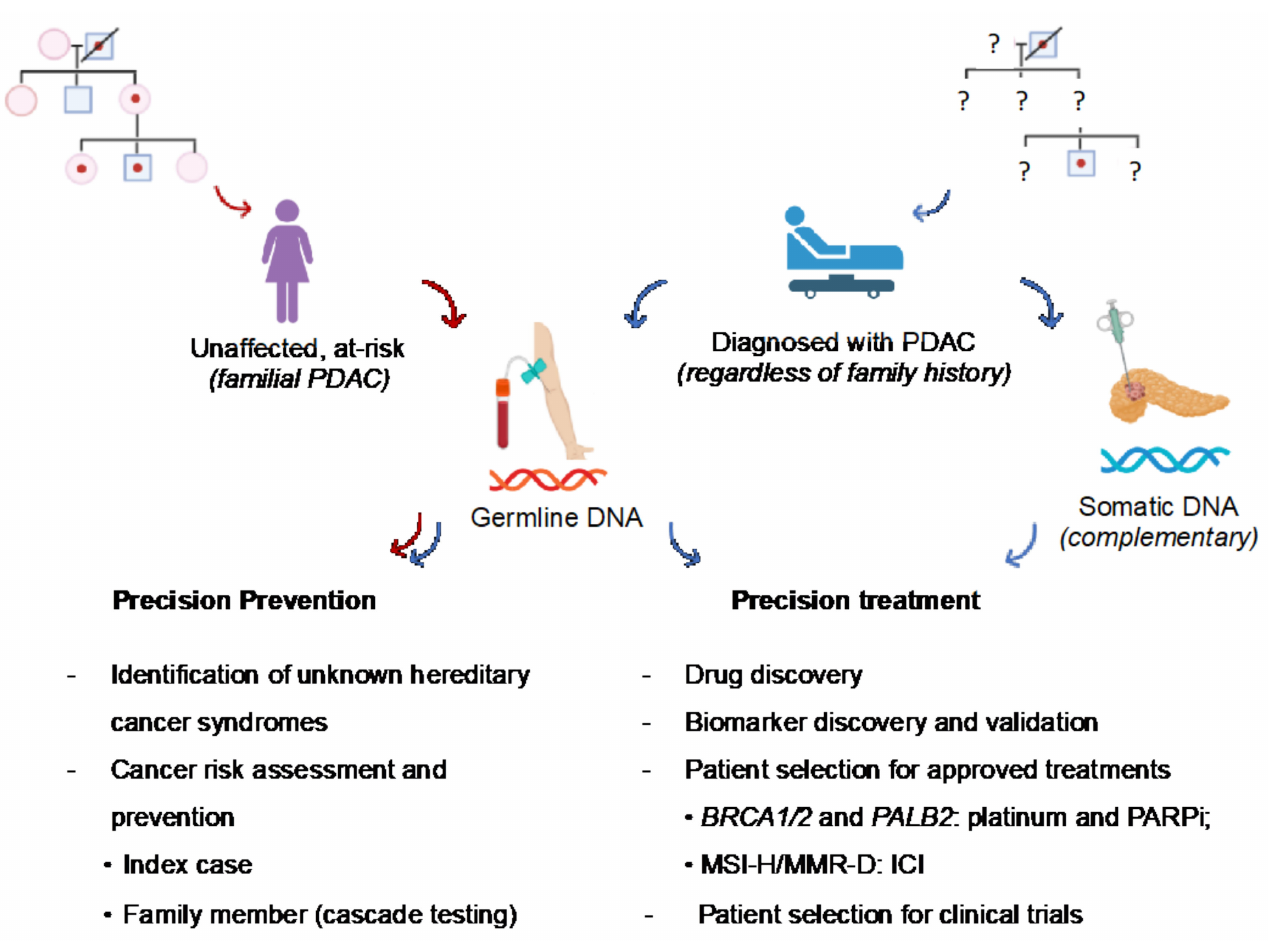
Figure 2. Overview of the clinical implications of germline variants in PDAC patients and at-risk subjects. Pathogenic germline variants are of key interest in PDAC owing to their therapeutic ac- tionability and implications for cancer prevention (downstream identification of at-risk relatives and possible hereditary cancer syndromes previously unknown in the family). Red arrow: pathway of healthy individuals at risk of PDAC based on family history. Blue arrow: pathway of patients with PDAC who should be tested for germline variants at diagnosis, regardless of family history. Complementary somatic analysis of tumor tissue may help the therapeutic decision (not standard recommendation, only in the research context). MMR-D: mismatch repair-deficiency; MSI-H: mi- crosatellite instability–high; PARPi: poly-ADP (adenosine diphosphate)-ribose polymerase inhibitors; ICI: immune checkpoint